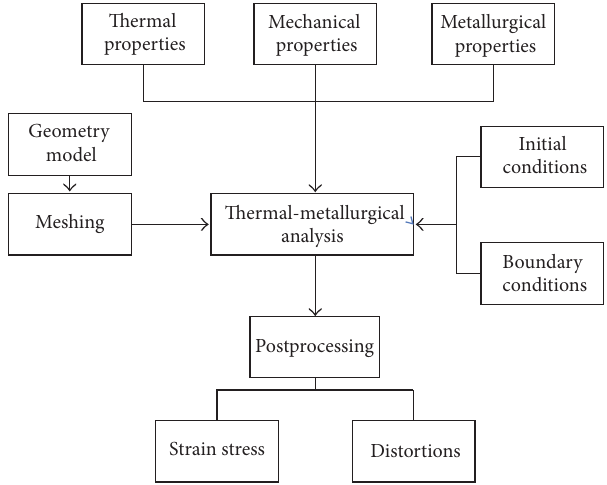
Figure 8: Flowchart of the welding simulation procedure.